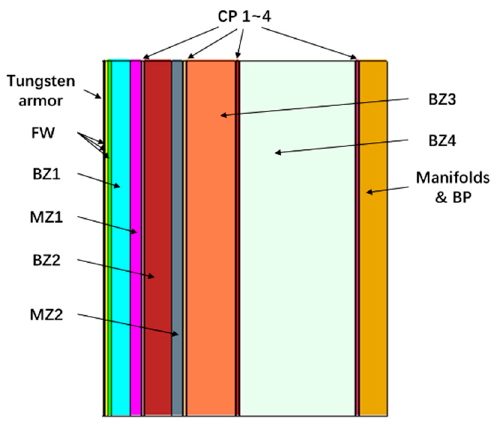
Figure 13. Radial layout of the 1D WCCB neutronics model.